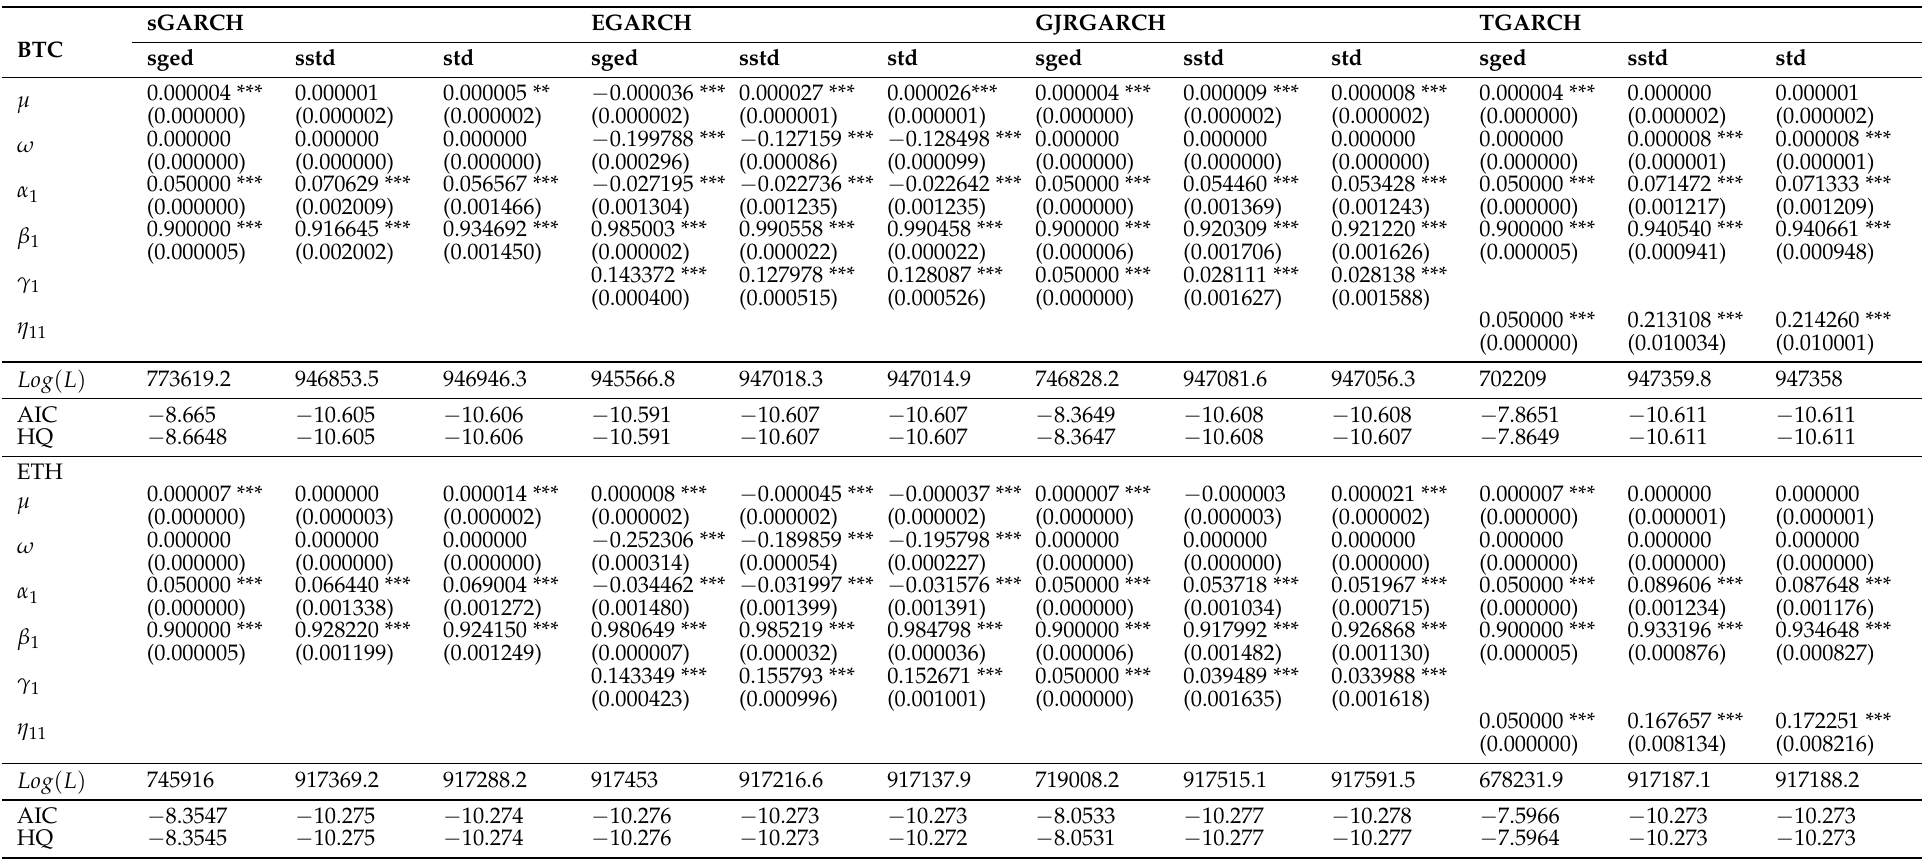
Table 4. Maximum likelihood estimates of the GARCH